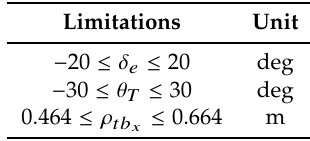
Table 2. Physical constraints of control inputs.